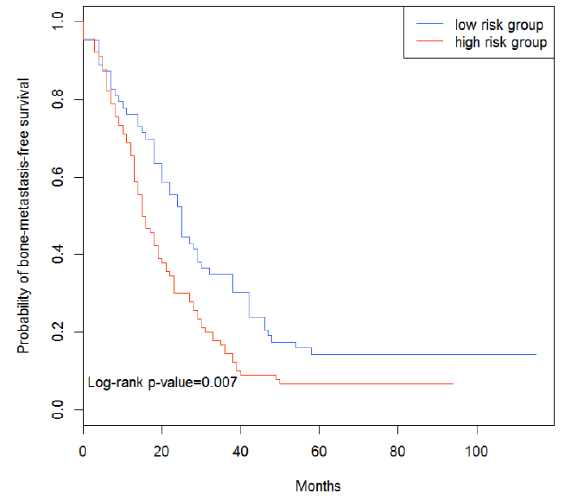
Figure 1. Survival analysis of test data set.